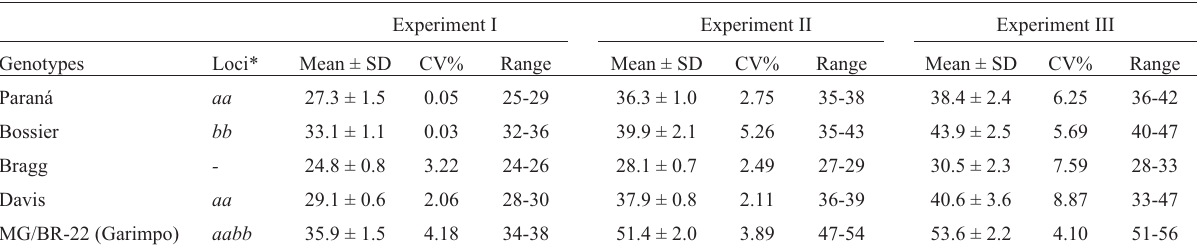
Table I - Means, standard deviation (SD), and range of the number of days to flowering of the soybean parent cultivars in experiments under short-day